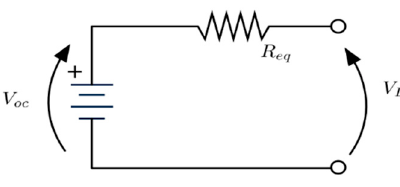
Figure 7. Battery equivalent circuit.